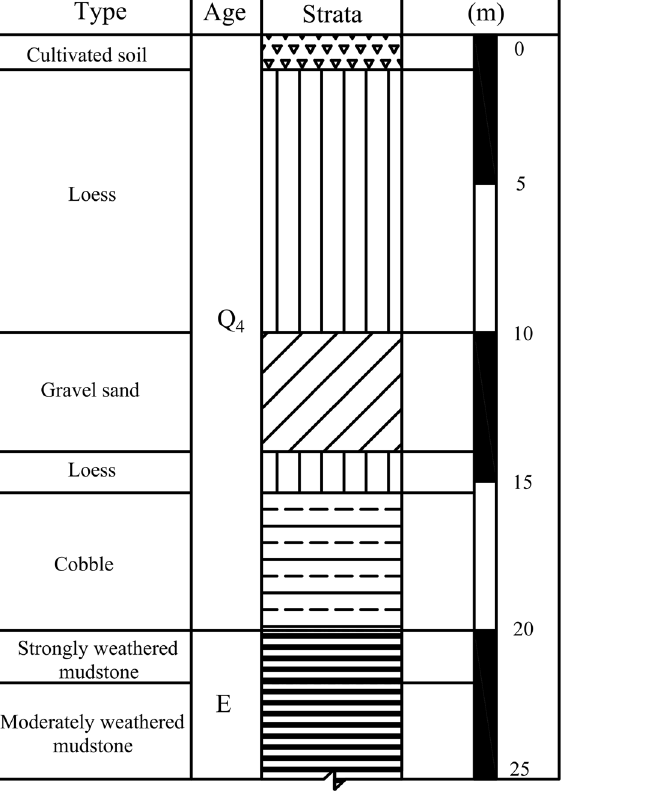
Figure 1. Stratigraphic profile of the study